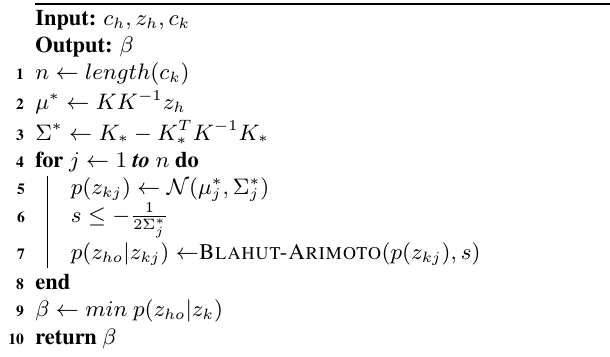
Algorithm 2: S ELF -R EDUNDANCY I DENTIFICATION